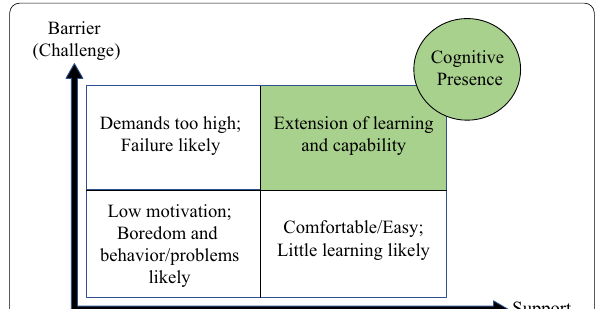
Fig. 6 Impacts of scaffolding on cognitive presence . The upper left quadrant, ‘demands too high; failure likely,’ is when barriers or challenges are not met with equal support, leading to a likely failure for the student. The lower left quadrant, ‘low motivation; boredom and behavior/problems likely,’ is generally seen when challenges and supports are both too little. The lower right quadrant, ‘comfortable/ easy; little learning likely,’ is when challenges are too low but supports are high. The upper right quadrant is when challenges or barriers and supports are equal, leading to an ‘extension of learning and capability’ Adapted from Hammond and Gibbons